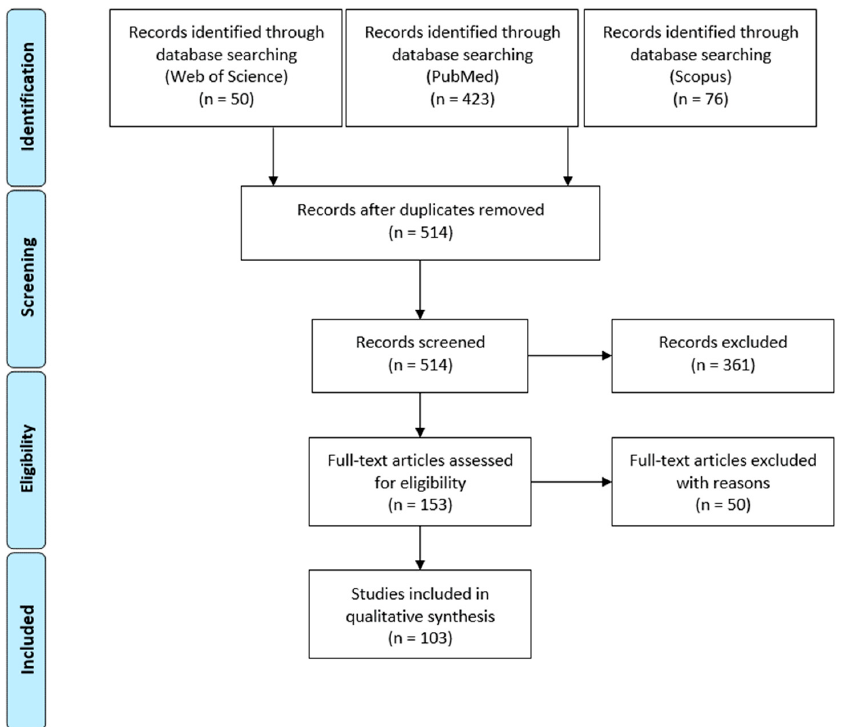
Figure 8. PRISMA scheme of publication selection.